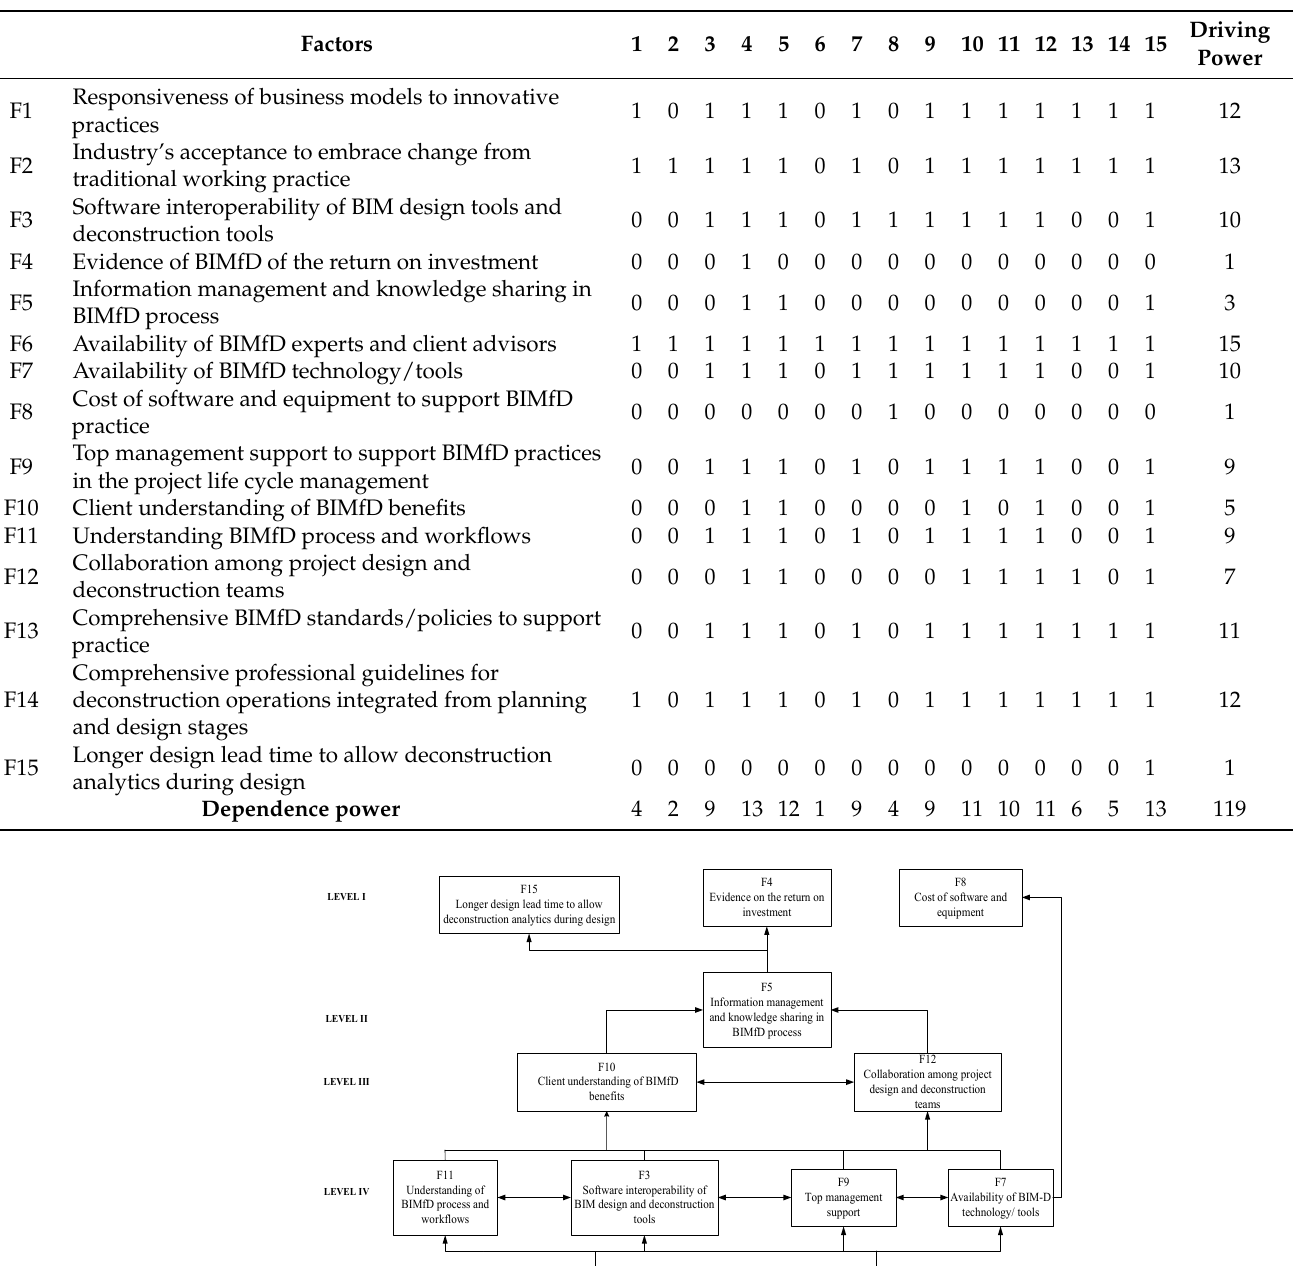
Table 6. Final reachability matrix.